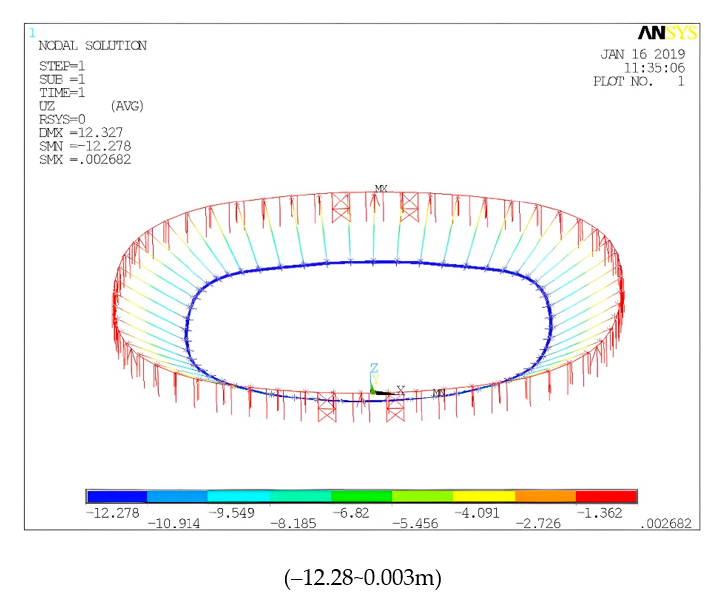
Figure 16. Typical Uz configuration (m). Table 8. Vertical deformation of lifted structure. Calculation Condition